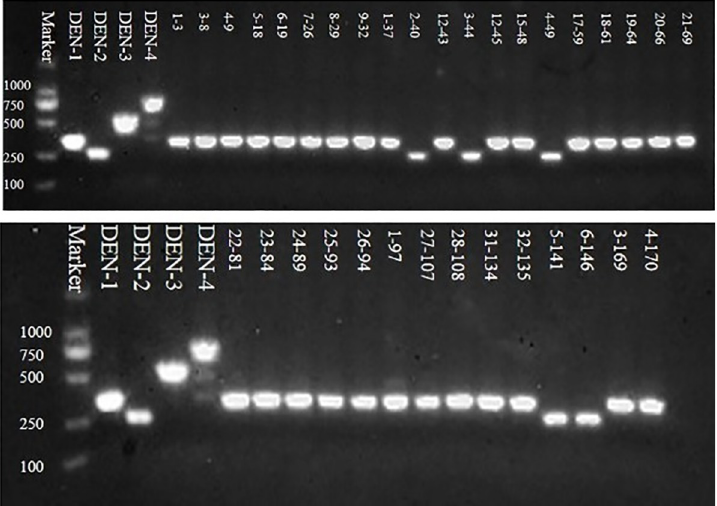
Fig 1. Gel electrophoresis analysis of RT-PCR products. According to the results from gel electrophoresis analysis of different samples given in the figure, there are 34 RT-PCR products; the sizes of the amplicons (ID 2–40, 3–44, 4–49, 5–141, and 6–146) are consistent with DENV-2, while the rest are consistent with